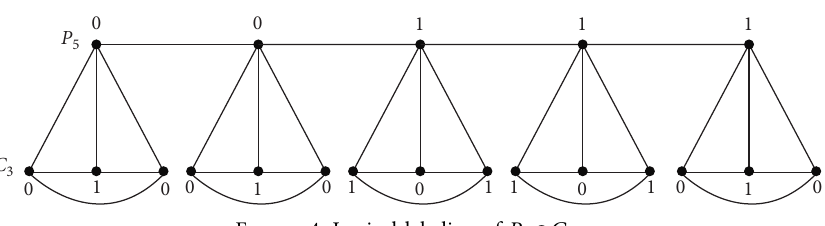
Figure 3: Logical labeling of P